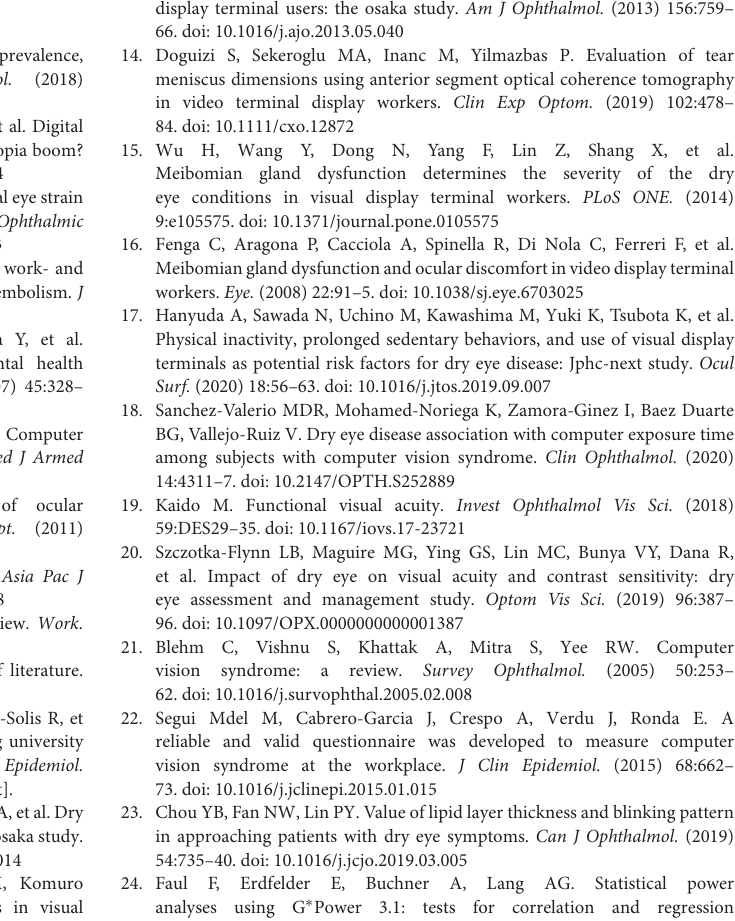
Supplementary Figure 1 | The LED screen used in the current